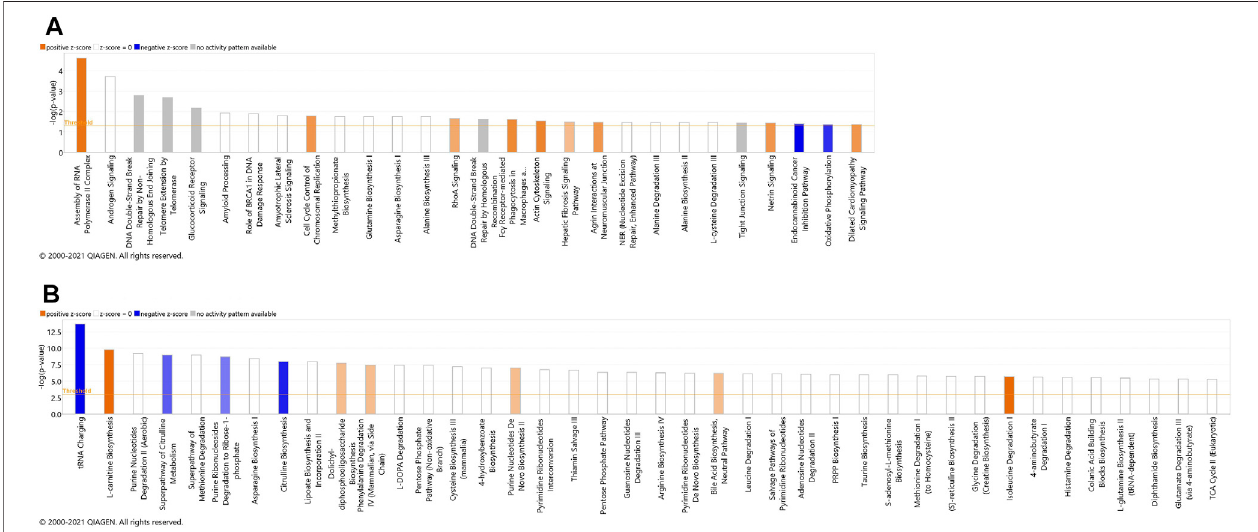
FIGURE 3 | Canonical pathways identi fi ed using IPA analysis, based on proteins (A) and metabolites (B) that were identi fi ed using label-free quanti fi cation proteomics (log